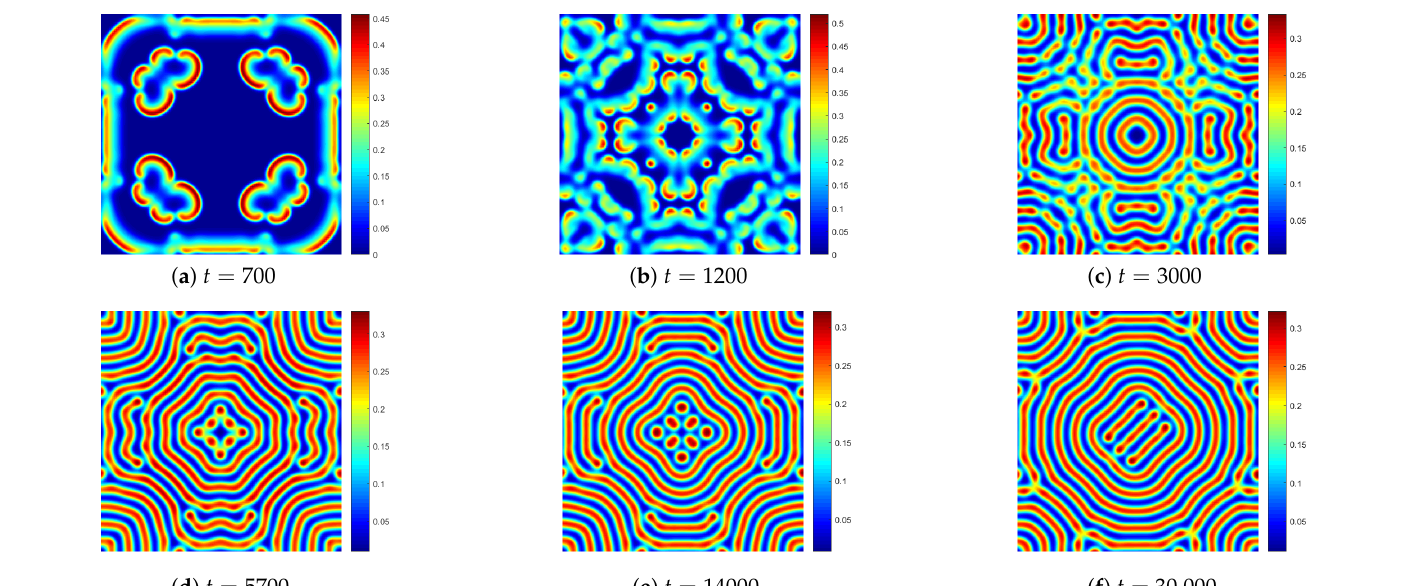
Figure 14. The patterns of u at α = β = 1.9 for Experiment 3 with D u = 2 × 10 − 5 , D v = 1 × 10 − 5 , F = 0.025, k = 0.055, L = 2, N = 128.